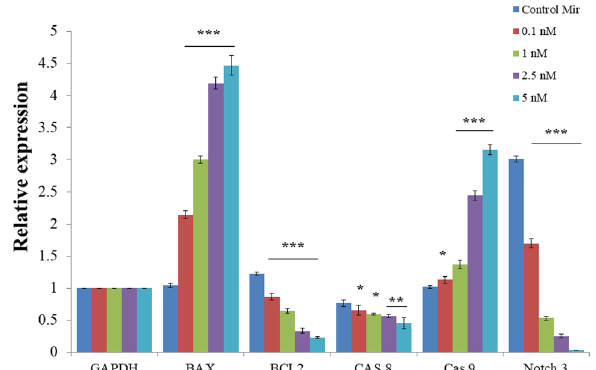
Figure 7. Determining Relative Expression of genes in MCF-7 cells after exposed to various concentration of MiRNA–PEG–Au NPs for 24 h using RT-qPCR. GAPDH was considered as endogenous control while expressions of BAX, BCL2, Caspase 8, 9 and Notch 3 were studied due to increase in mitochondrial membrane potential and NOTCH 3 being directly associated with miRNA 206. Values represents mean ± S.E. of three independent experiments (*p < 0.05, **p < 0.001).